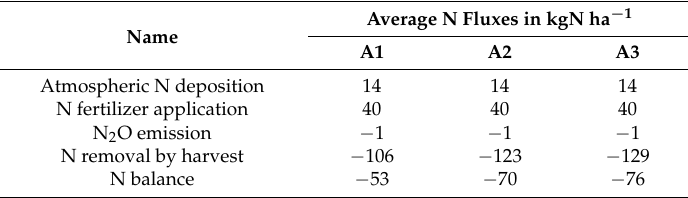
Long-term average (1997–2009) and balance of measured N fluxes for the Linden FACE